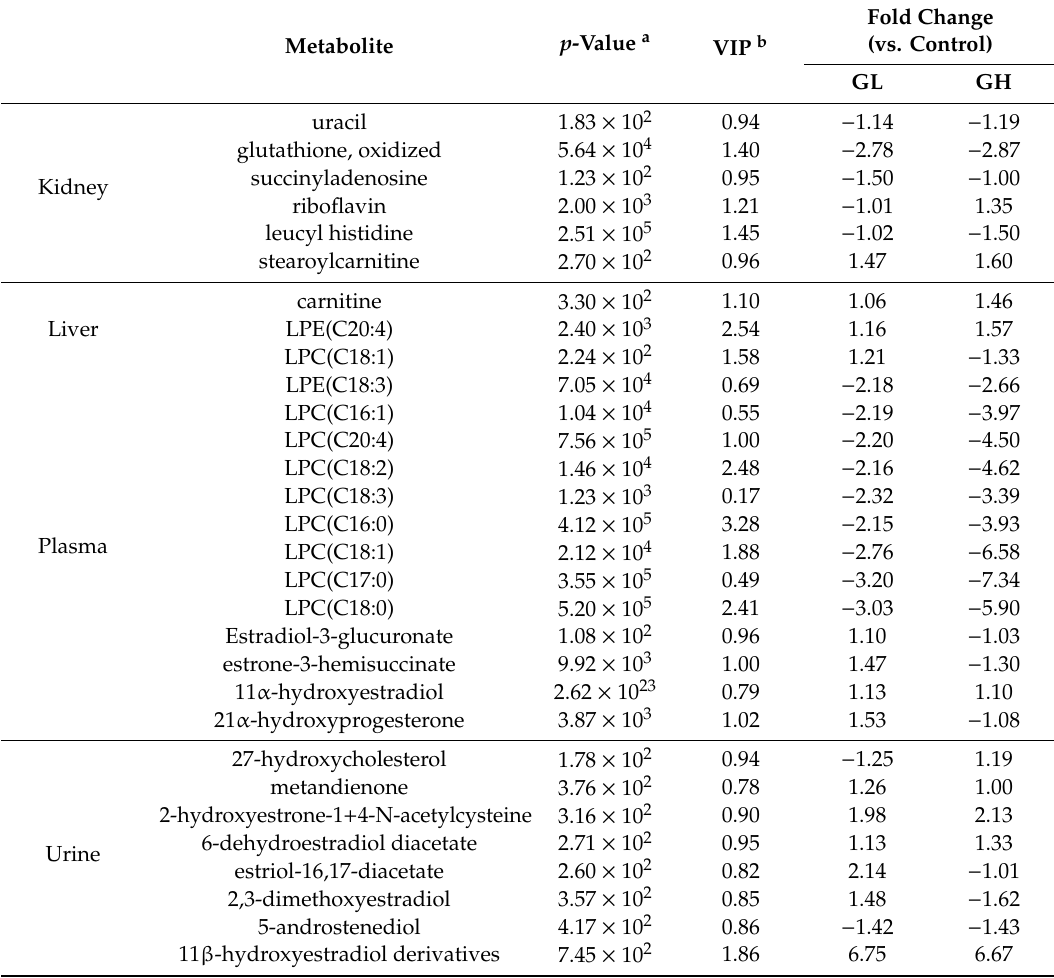
Table 2. Identified metabolites list obtained from UPLC-Q-TOF MS and identified sterol metabolites from multiple reaction monitoring (MRM) data of rats fed